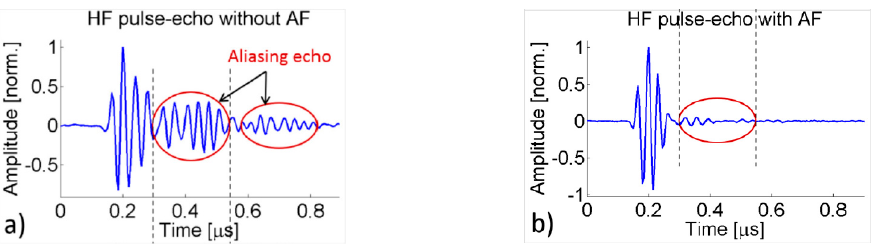
Figure 20. Acoustic filter design calculation using a Smith chart showing the loci of reflection coefficient normalized to the impedance of the piezoelectric material. The numbers followed by AM indicate relative impedance. Reprinted from [190], with the permission of AIP Publishing.